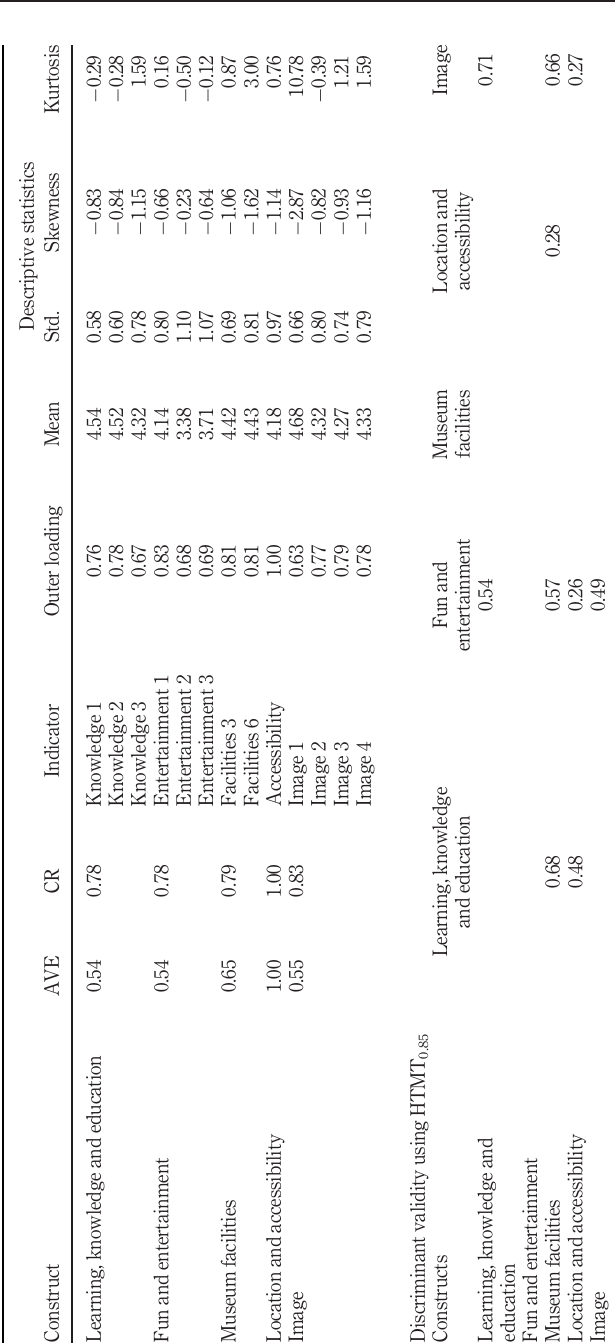
Table 5. Measurement model and study variables descriptive